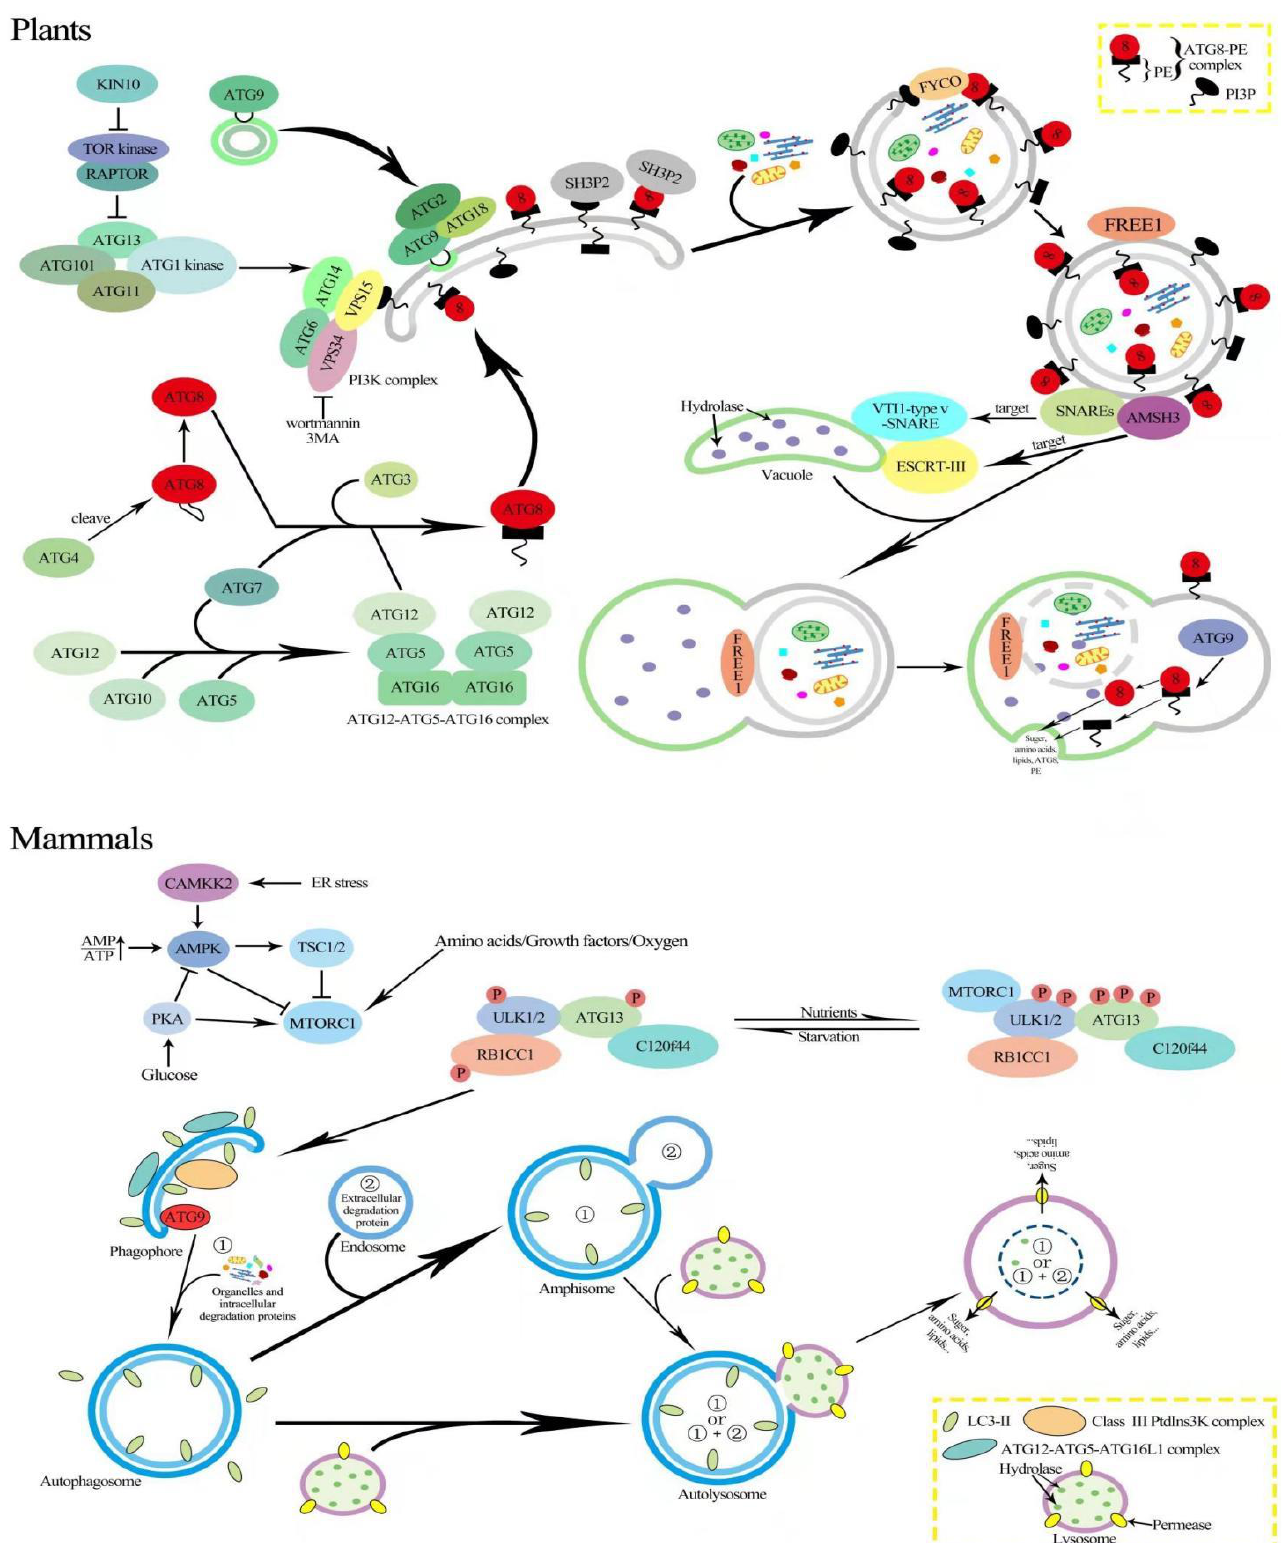
Figure 1. Schematic illustration of autophagy regulation in plants and animals. Autophagy is activated by inhibiting TOR and is blocked when TOR is overexpressed. Autophagy is triggered by the formation of an active complex between ATG13, ATG1, ATG11, and ATG101, as well as ATG11 and ATG101, which activates autophagy. Autophagosome development comprises membrane delivery, nucleation, expansion, and closure of the phagophore. ATG9 is employed in the transport of lipids to the expanding phagophore, together with ATG2 and ATG18. PI3P decoration is generated by the VPS34 lipid